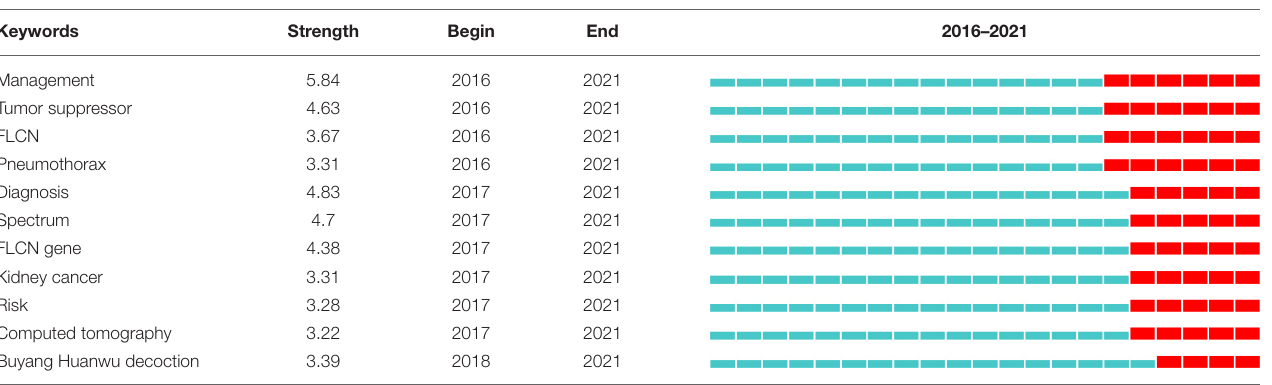
TABLE 9 | The strongest citation bursts keywords after